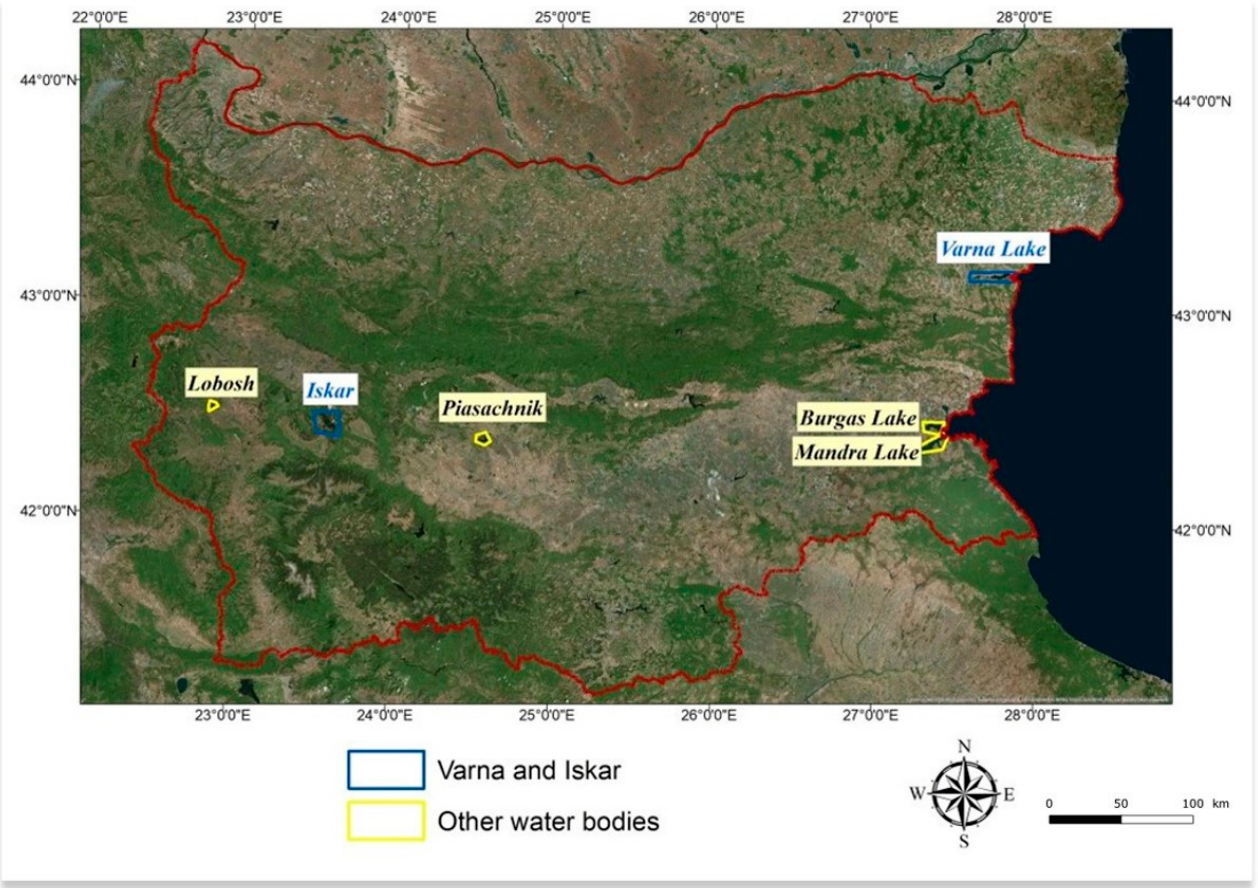
Figure 4. Overview map of the pilot water bodies in the EMOWAF project: pilot area 1—Iskar Dam Lake and pilot area 2—Varna Lake.